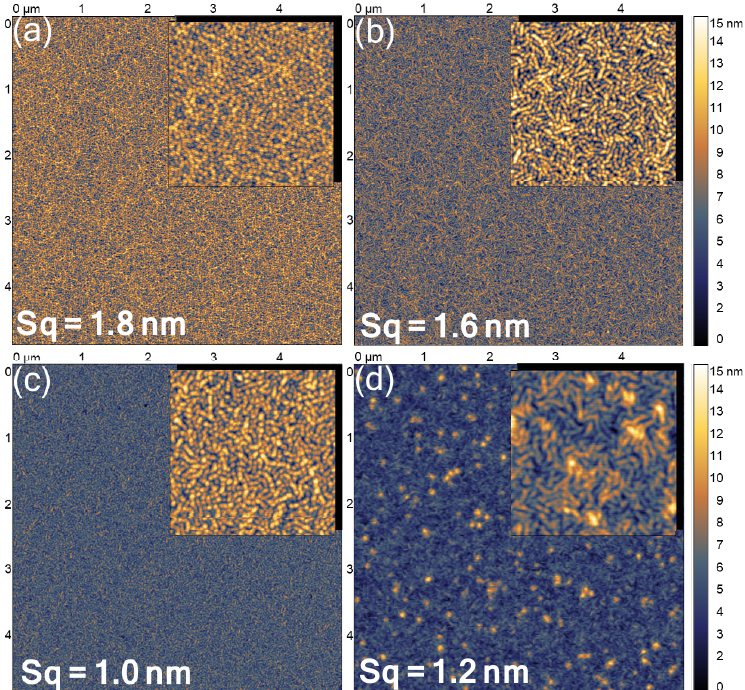
Figure 2. Surface morphology of the thin films with the following Sc content, x = ( a ) 0 (AlN), ( b ) 0.14, ( c ) 0.32, ( d ) 0.41 obtained via AFM. The sample with x = 0.23 is not shown. The false colour scale is common for all images. The rms roughness, Sq , values is indicated on the corresponding images. Insets: complimentary 1 × 1 µ m 2 AFM